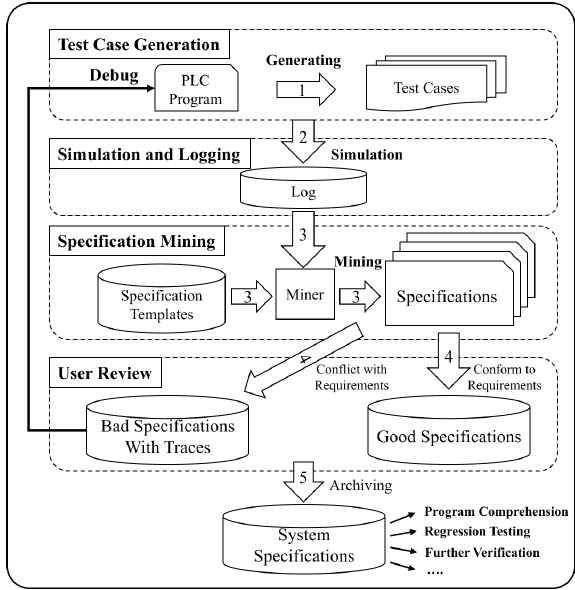
Figure 1. The overview of our